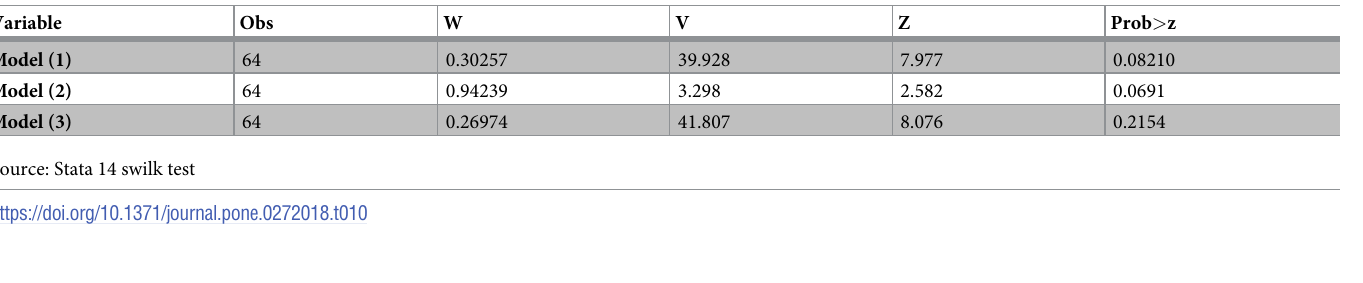
Table 10. Normality test: